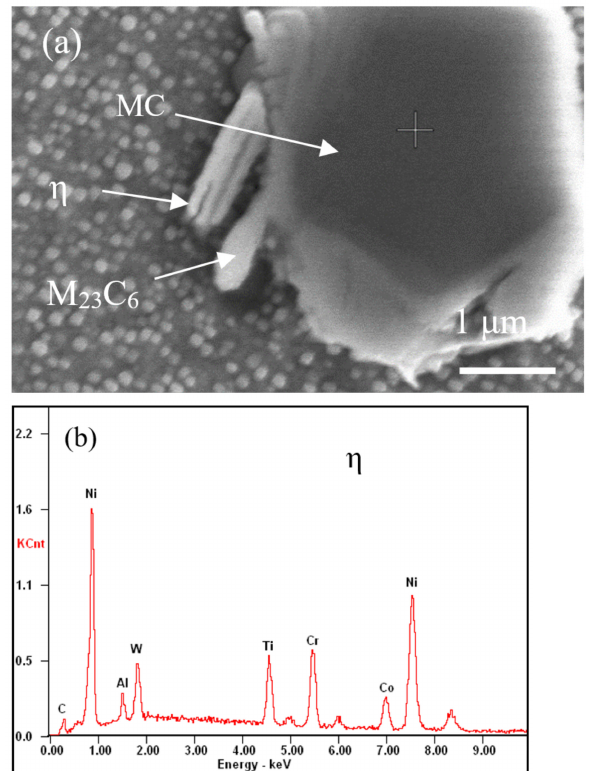
Figure 5. ( a ) Morphologies of the MC, M 23 C 6 and η phases; ( b ) EDS of the η